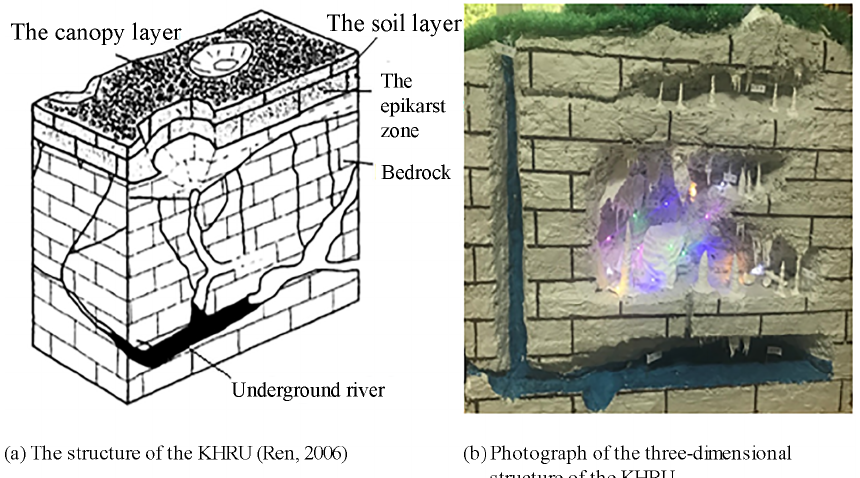
Figure 10. Sketch map of the